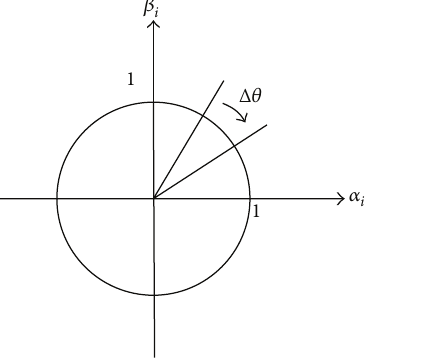
Figure 2: Quantum spin in the revolving door program.